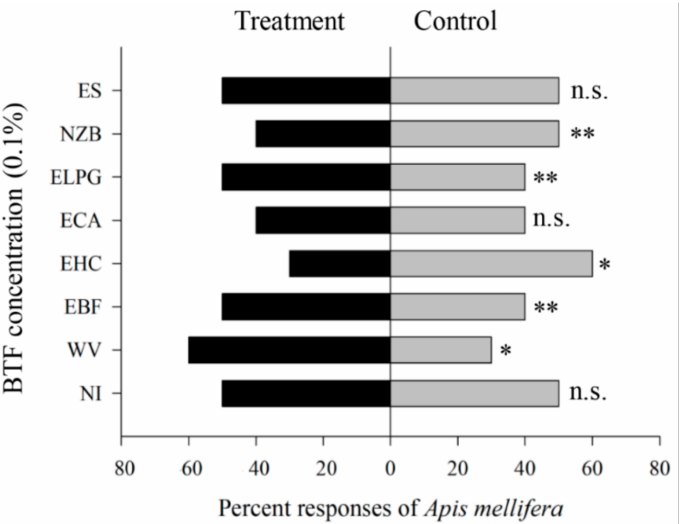
Figure 3. Olfactory responses of Apis mellifera to odors of various BTF (0.1%) components versus clean air in a Y-tube olfactometer. Ten adult worker bees were tested for each BTF component. Asterisks indicate significant differences: * p < 0.05 and ** p < 0.01 (Fisher’s exact test). “n.s.” indicates no significant difference between the treatment and control ( p > 0.05; Fisher’s exact test). ES, extract of seaweed; NZB, nitrogen, zinc, boron; ELPG, extract of low quality fresh Panax ginseng ; ECA, extract of Chenopodium ambrosioides ; EHC, extract of Houttuynia cordata ; EBF, extract of Bupleurum falcatum ; WV, wood vinegar; NI, inert ingredient.